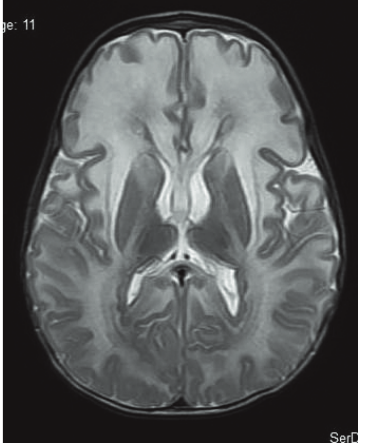
Fig. 1. T2W image shows bilaterally symmetrical white matter hyperintensities with frontal predominance and involvement of heads of the caudate nuclei.